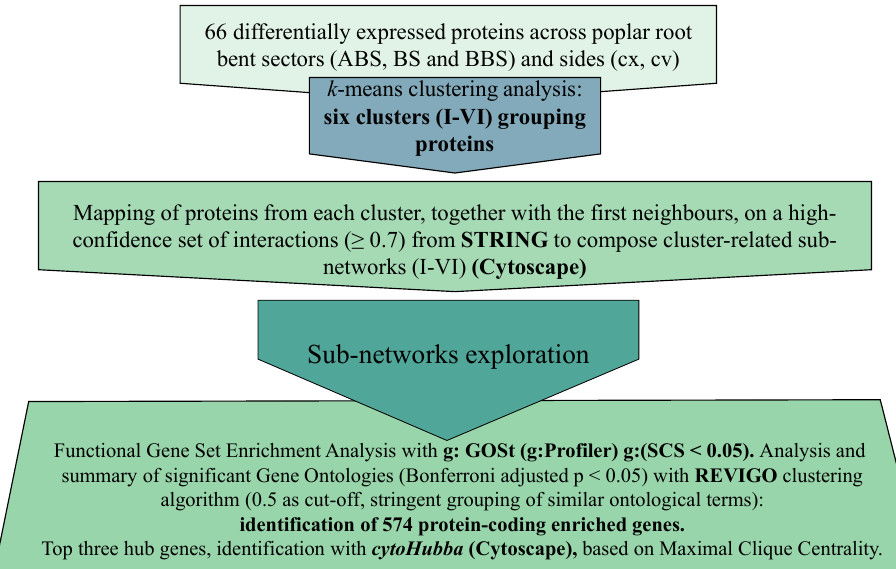
algorithm (0.5 as cut-off, stringent grouping of similar ontological terms): identification of 574 protein-coding enriched genes. Top three hub genes, identification with cytoHubba (Cytoscape), based on Maximal Clique Centrality. Figure 1. Summary of bioinformatic pipeline. The 66 protein spots found differentially represented among bent sectors and sides [9] were used to perform the network-based analysis. In particular, all protein spots were grouped according to their abundance profile patterns (k-means analysis) and mapped, together with their first neighbours, on a high-confidence set of interactions from STRING to compose specific cluster-related subnetworks (I–VI). Successively, all subnetworks were explored by a functional gene set enrichment analysis to identify enriched gene ontology (GO) terms across the three domains—biological process (GO-BP), molecular function (GO-MF), and cellular component (GO-CC)—and summarized by REVIGO. Subnetworks were then analysed by cytoHubba (Maxi- mal Clique Centrality algorithm) to identify the top three hub genes strongly interconnected with other